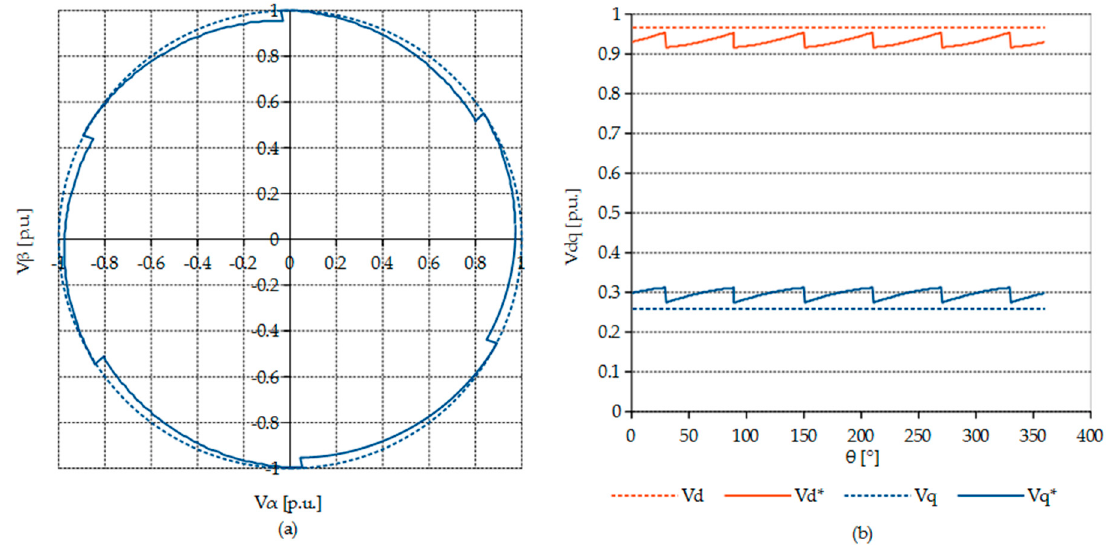
Figure 6. The inverter reference (dashed) and distorted (solid) output voltage in ( a ) the stationary αβ reference frame and ( b ) in the rotor-fixed dq reference frame; t (cid:2914)(cid:2930) = 5% of 𝑇 ; ∆𝑉 (cid:2903)(cid:2888) = 5% of 𝑉 (cid:2888)(cid:2887) ; power factor, 0.5 ; load angle, 15°.